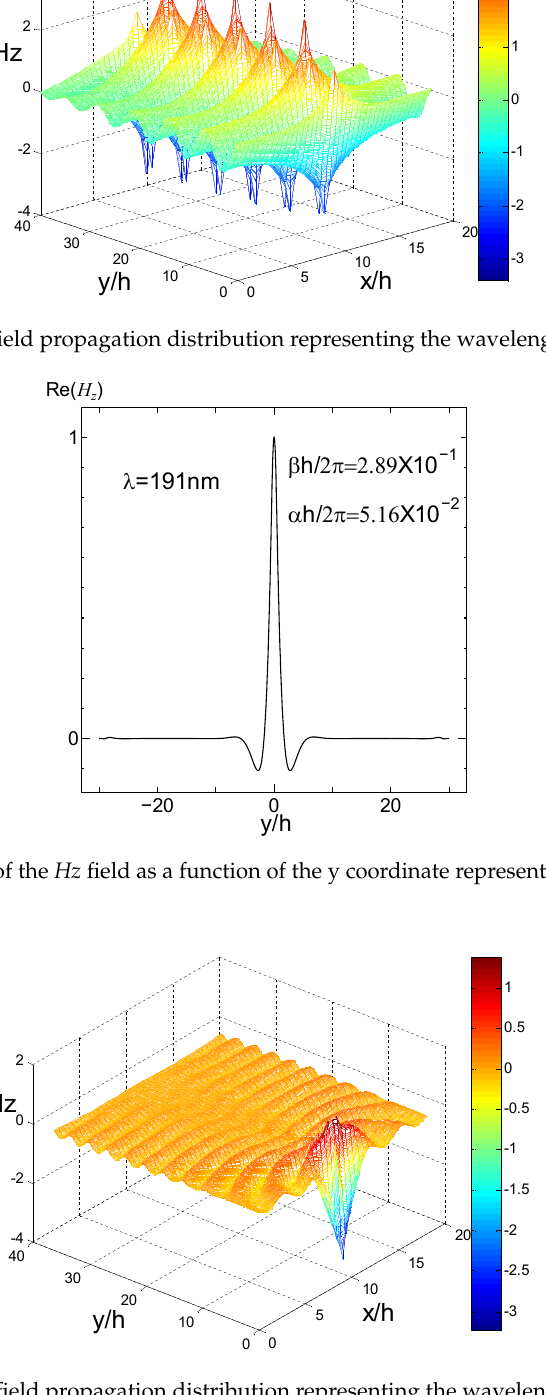
Figure 11. Near field propagation distribution representing the wavelength of 191 nm.